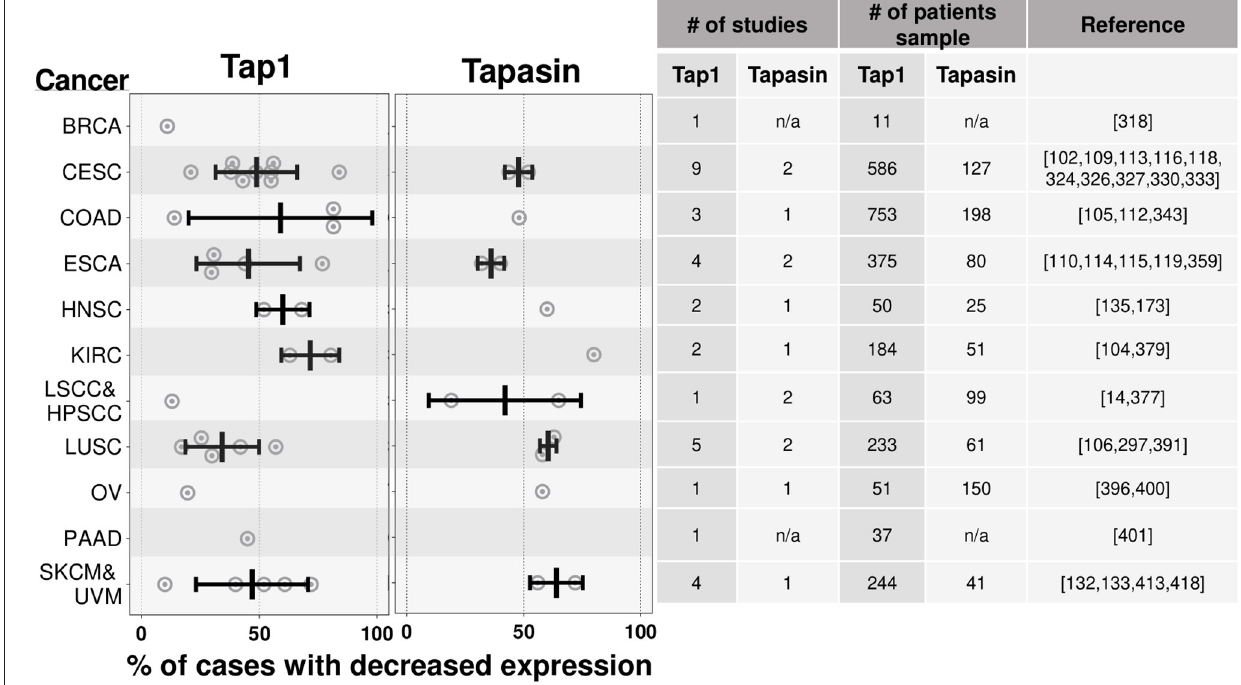
FIGURE 5 | Tap1 and Tapasin are downregulated in many cancer types. Similar to Figure 4 , except summarizing results from studies quantifying loss of Tap1 (one of the chains of the TAP transporter) and Tapasin, instead of MHC I. There are fewer studies of the expression of these proteins in cancers relative to the studies of MHC I expression in cancers. n/a-data is not available. Cancer abbreviation are as in Figure 4 .